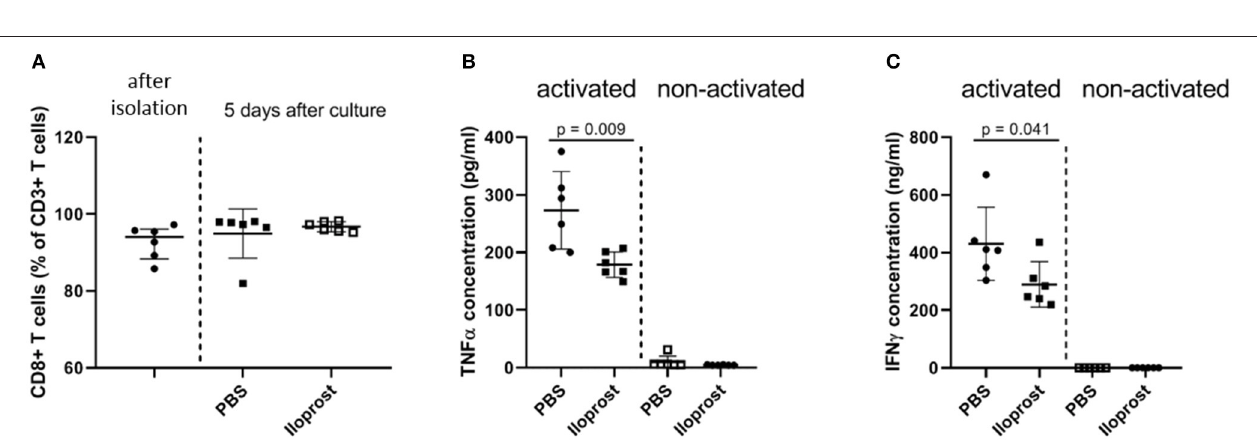
FIGURE 2 | Immunomodulatory effects of Iloprost on bone marrow cells. Bone marrow cells were stimulated for 2 days by α -CD3/ α -CD28 in addition to either PBS or two different concentrations of Iloprost (300nM or 3 µ M, respectively). The following secreted cytokine concentrations were evaluated: IFN γ (A) and TNF α (B) . The metabolic activity of the stimulated bone marrow cells was measured via Prestoblue (C) . n = 6.